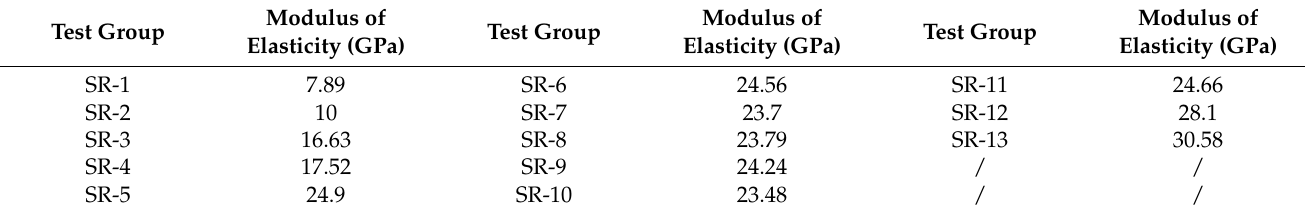
Table 5. Tensile modulus E c value of steel–plastic compound geogrid-reinforced belt with different reinforcement ratios. Modulus of Test Group Elasticity